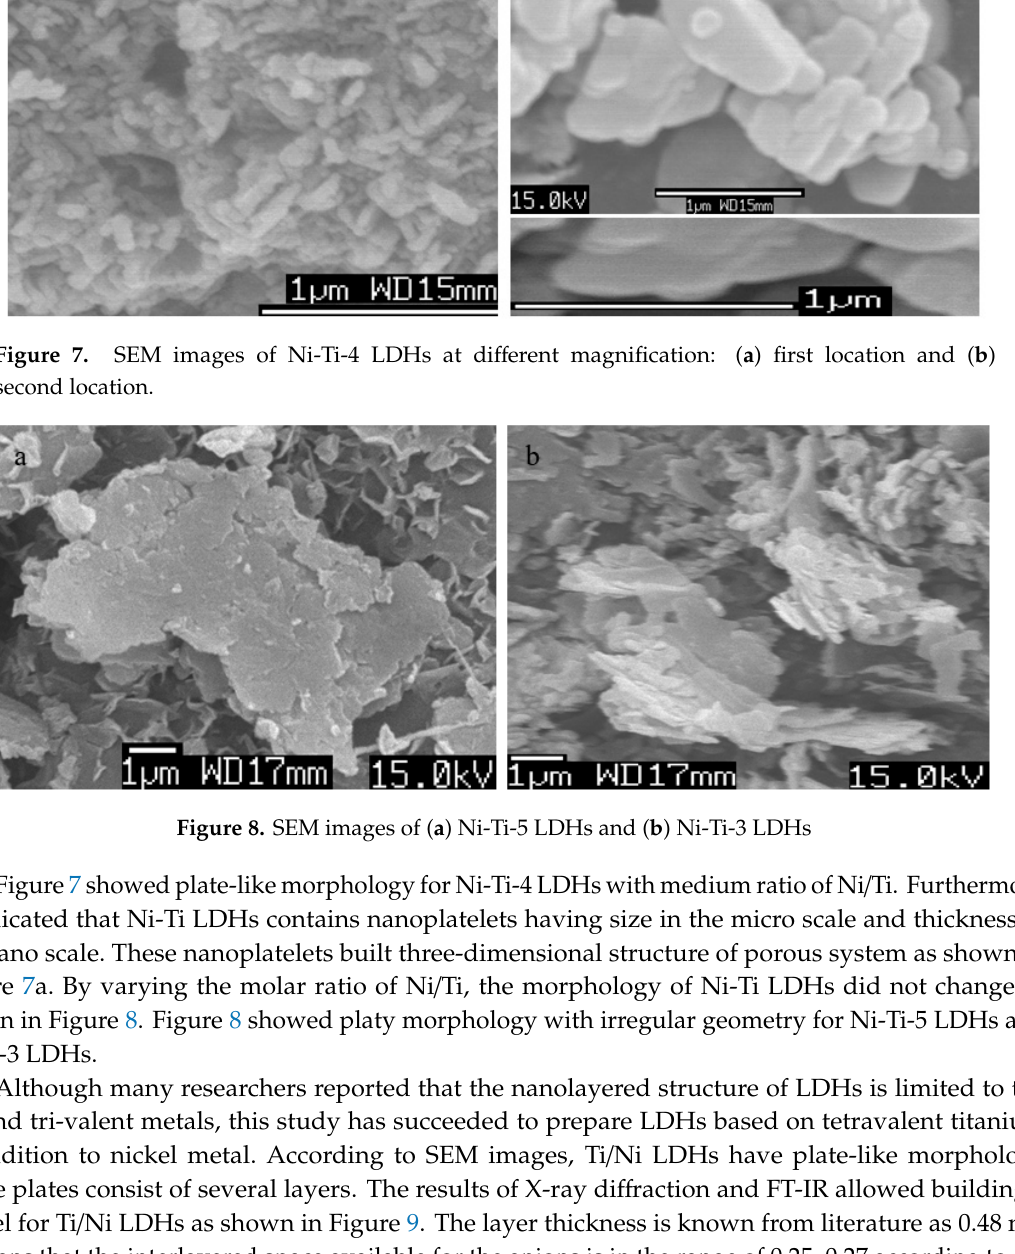
Figure 9. Schematic representation of Ti/Ni LDHs.